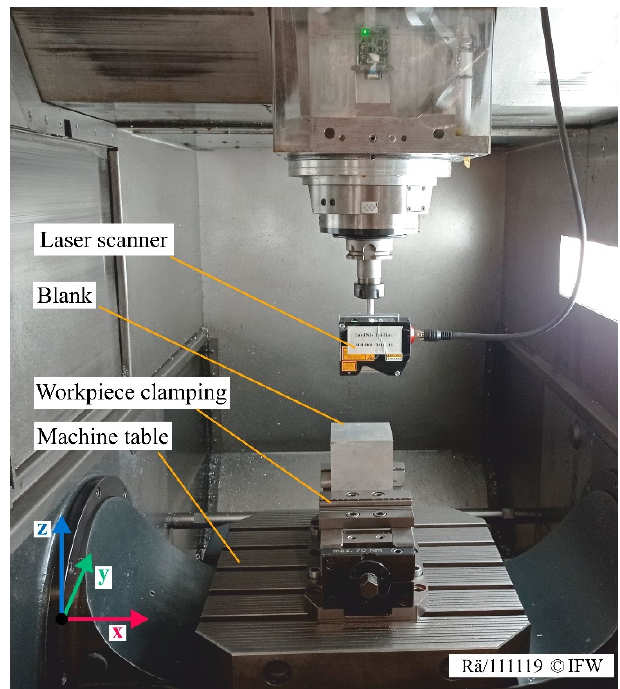
Figure 12. Experimental design for the proposed investigation.